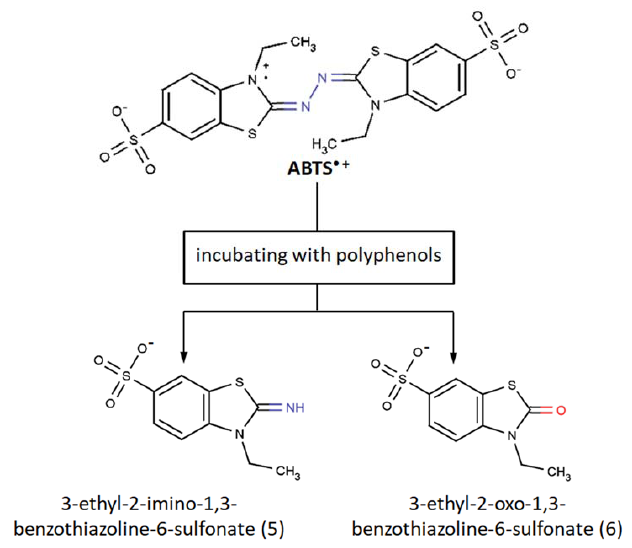
Figure 4. Products of ABTS •+ degradation [75].